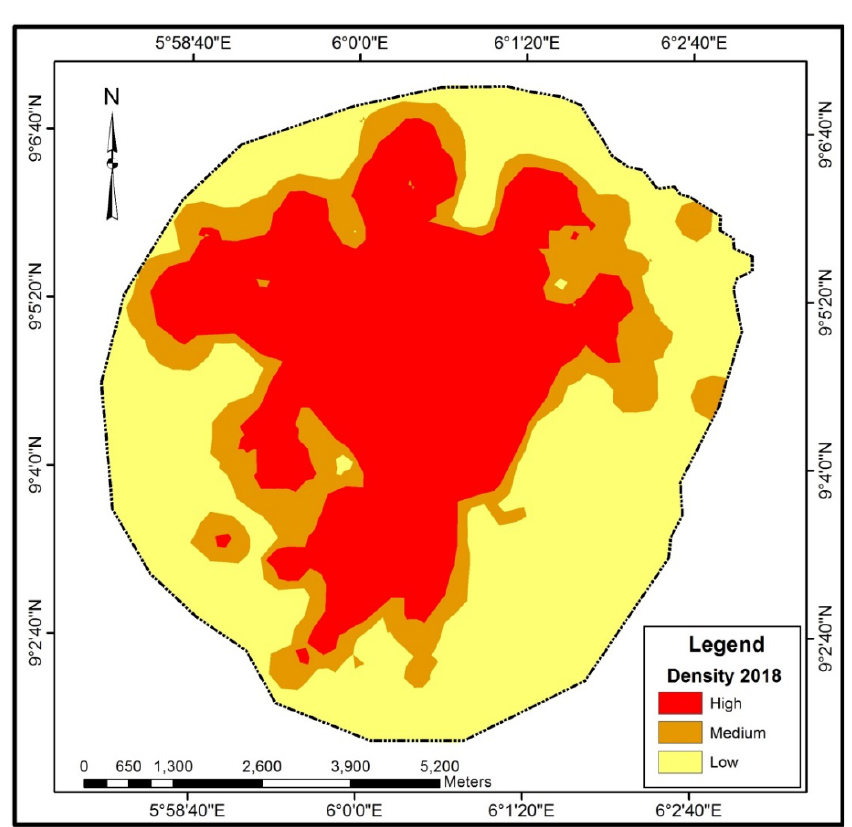
Fig. 8. Residential density classification for the year 2018 (Developed by the authors,